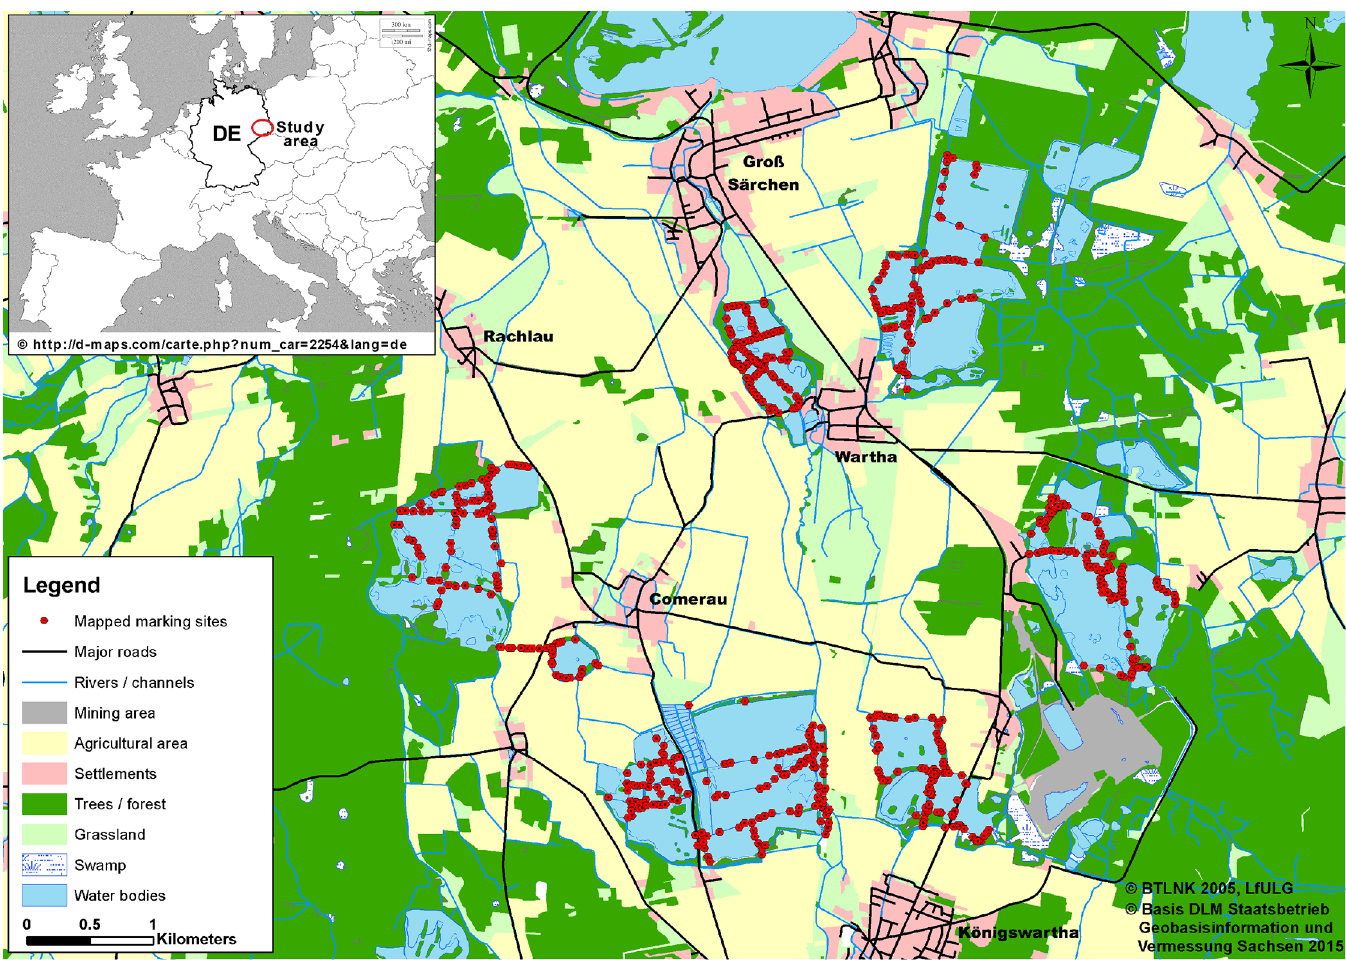
Fig 1. Study area map with recorded otter marking sites. Location of otter marking sites (red hexagons) in seven pond areas and one single pond in the Upper Lusatia (Saxony, Germany), where we searched for fresh faeces for genetic capture-mark-recapture (CMR) analyses (2006 – 2012). Main land use types of the surrounding area are